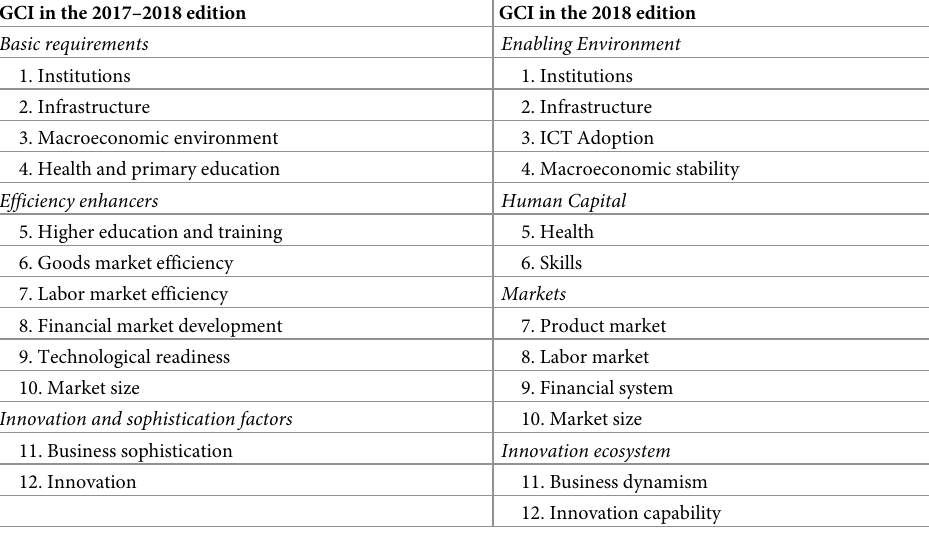
Table 1. The pillar structure of the GCI in the 2017–2018 and in the 2018